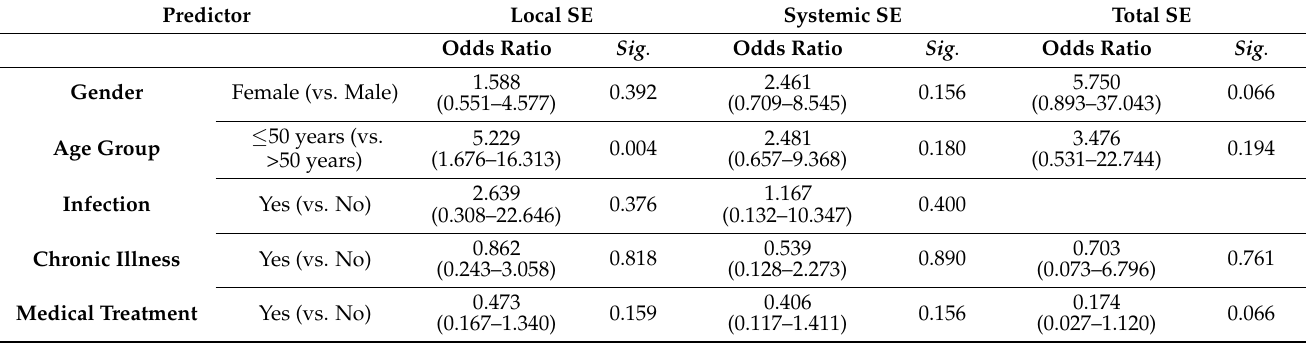
Table 6. Regression analysis of AstraZeneca COVID-19 vaccine side effects’ risk factors, February–March 2021. Predictor Local SE Systemic SE Total SE Odds Ratio Sig . Odds Ratio Sig . Odds Ratio Sig